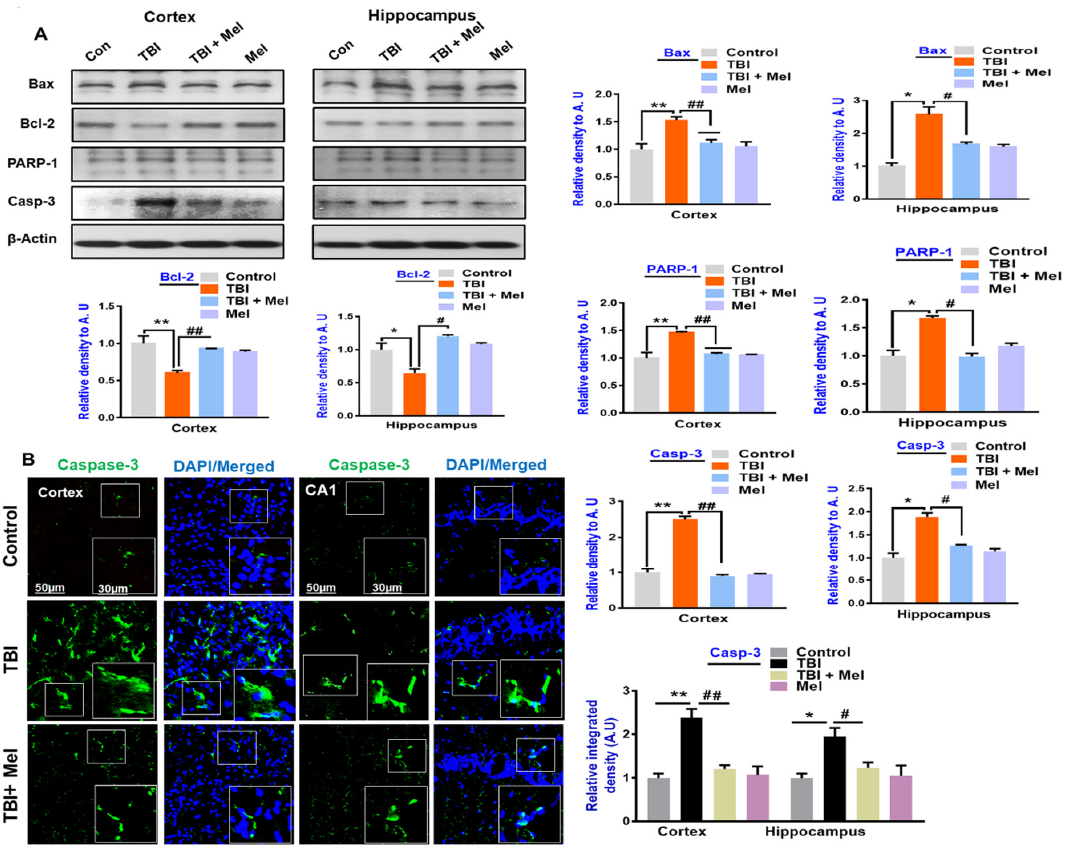
Figure 4. Melatonin modulates the expressions of c ‐ Jun N ‐ terminal kinase (p ‐ JNK) and enhances cell survival in the repetitive mild traumatic brain injury (rmTBI) ‐ mouse model. ( A ) Representative immunoblots and histograms showing p ‐ JNK expressions in the cortex and hippocampus of the experimental groups, with bar graphs. n = 10 mice per group. The beta ‐ actin antibody was used as a loading control. Western blot bands were quantified through SigmaGel software. ( B ) Shown are the confocal microscopic results representing P ‐ JNK expressions in the different experimental groups, with respective bar graphs. ( C ) Confocal microscopy results indicating the FJB staining in the cortical region of the rmTBI and rmTBI plus melatonin ‐ treated mice group. n = 5 mice per